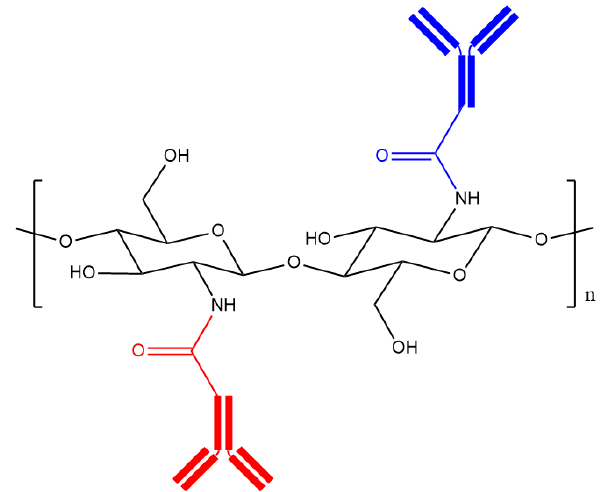
Figure 5. The structure of chitosan functionalised with two different antibodies (an antibody is shown in red and the different antibody is shown in blue).